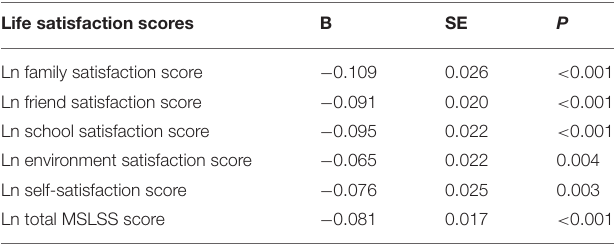
TABLE 2 | Association between bullying victimization and different aspects of children’s life satisfaction.